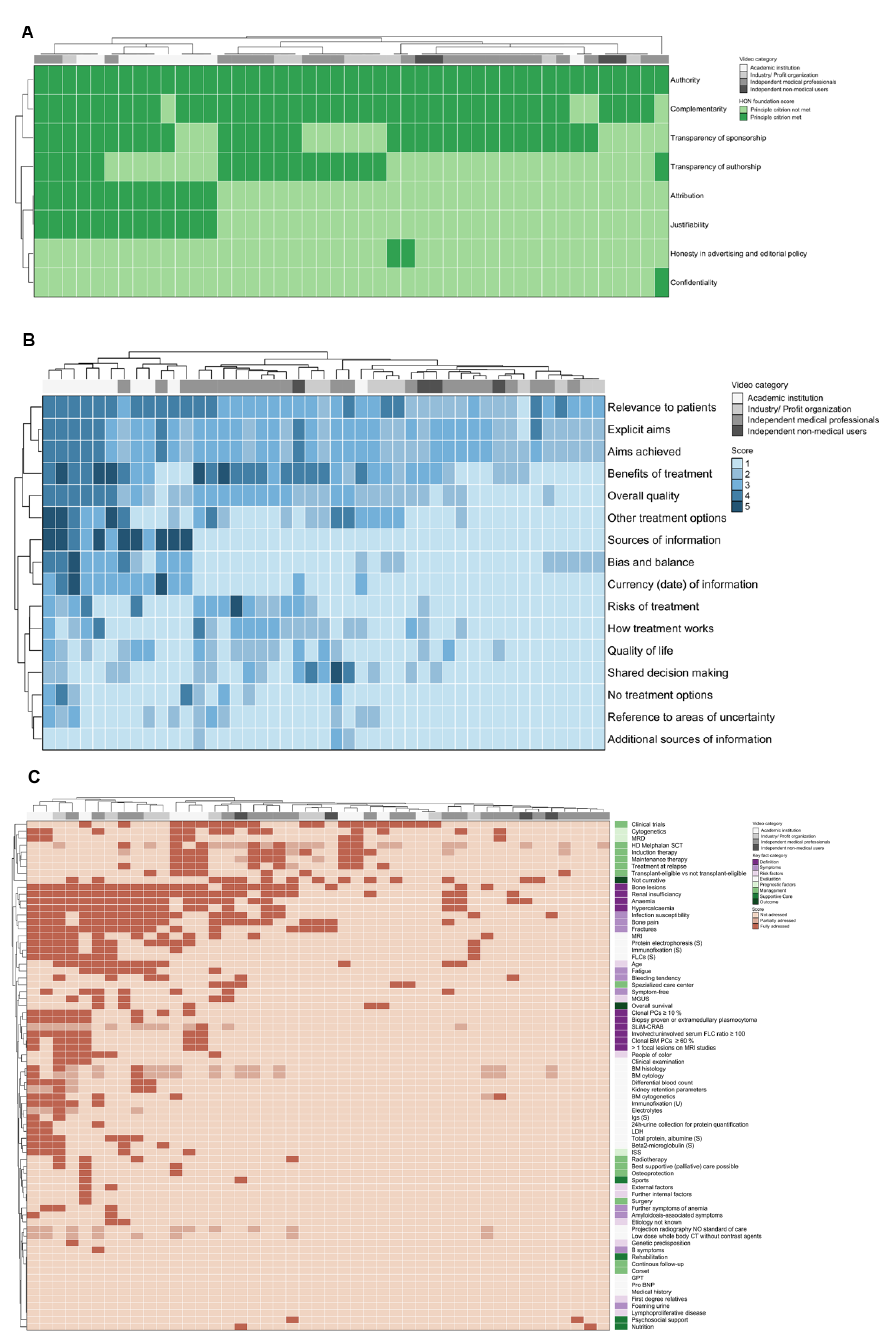
Figure 4. Characterization of videos by category. ( A ) Unsupervised hierarchical clustering was performed by HON foundation score items (rows) and single videos (columns, n = 45). The video category is shown in the top row of the heatmap. ( B ) Unsupervised hierarchical clustering was performed by DISCERN score items (rows) and single videos (columns, n = 45). Item 2. “aims achieved” displays not assessable (NA) scores, as it was only assessable if item 1. “explicit aims” was not scored with 1. The video category is shown in the top row of the heatmap. Websites provided by academic institutions cluster on the left side of the heat map, indicating a higher number of addressed DISCERN score items. ( C ) Unsupervised hierarchical clustering was performed by key fact score items (rows) and single videos (columns, n = 45). The video category is shown in the top row and the key fact item category is in the last column of the heatmap. No obvious clusters of video categories were